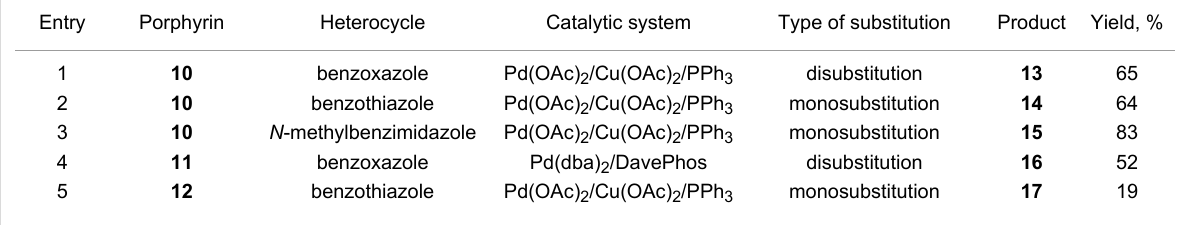
Table 3: Diarylation of zinc di- meso -(bromophenyl)porphyrinates 10–12 with benzothiazole, benzoxazole and N